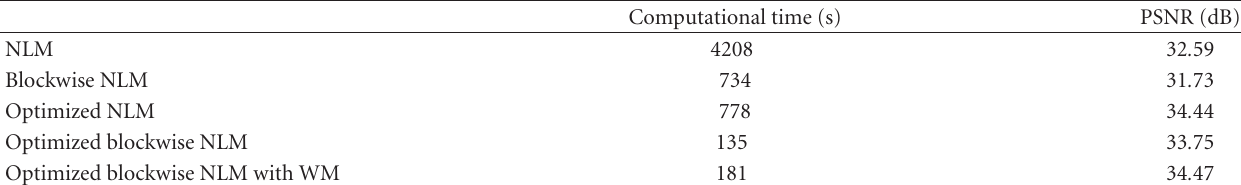
Table 1: Comparison of di ff erent implementations of NL-means in terms of computational time and denoising quality. The computational time was obtained with multithreading on a DualCore Intel(R) Pentium(R) D CPU 3.40 GHz. These results were obtained on a T1-w phantom image of 181 × 217 × 181 voxels with 9% of noise.